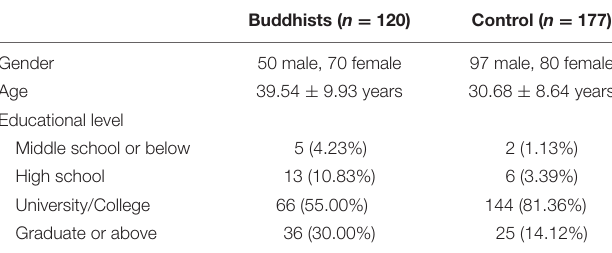
TABLE 1 | Demographics of the Buddhist and control